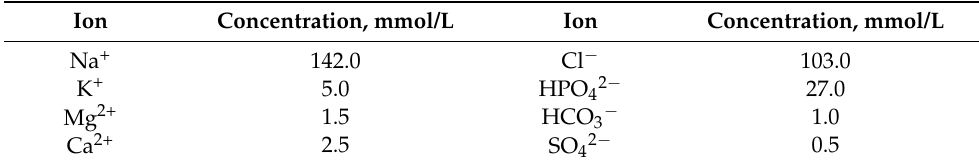
Table 2. Concentrations of ions included in SBF solution